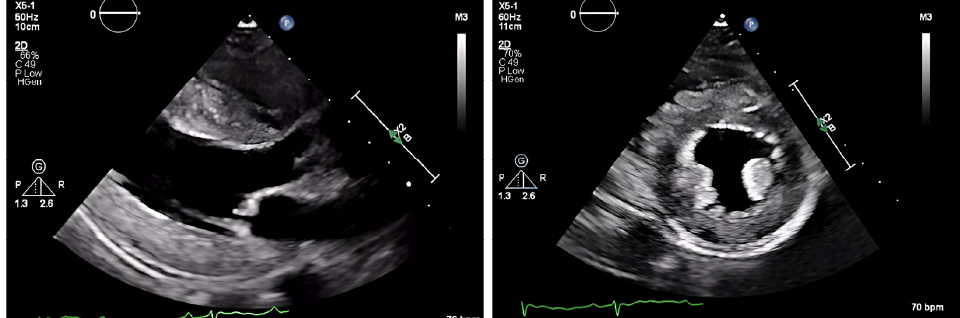
Figure 2. ECHO showing a discrepancy between the wall mass and electrical activity on ECG.